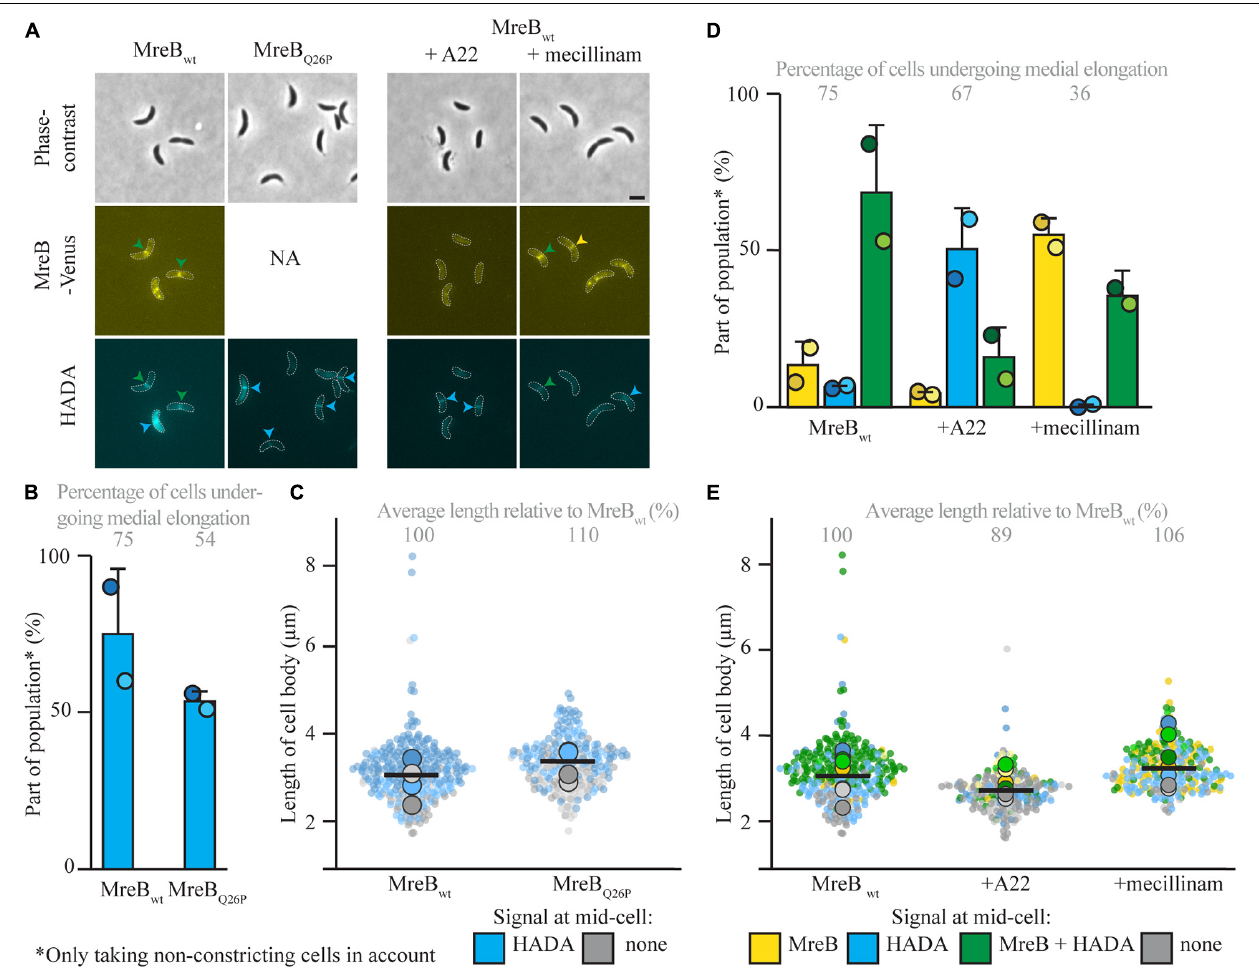
FIGURE 3 | Medial elongation can take place in the absence of elongasome components at midcell. Light microscopy images (A) and respective quantification of strains CJW1715